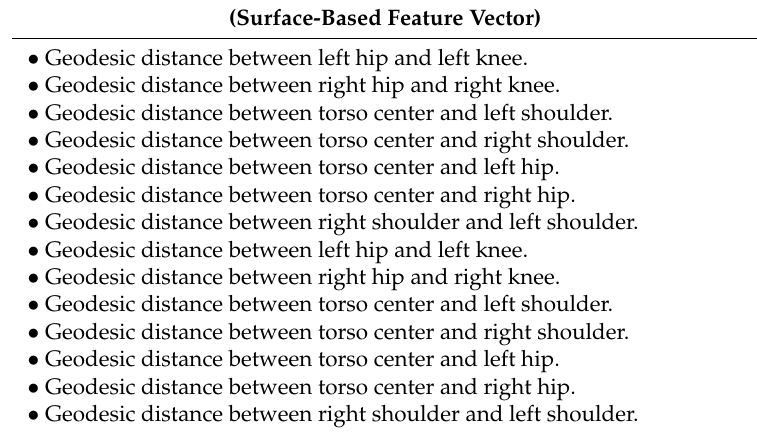
Table A3. geodesic distances among the projection of selected skeleton